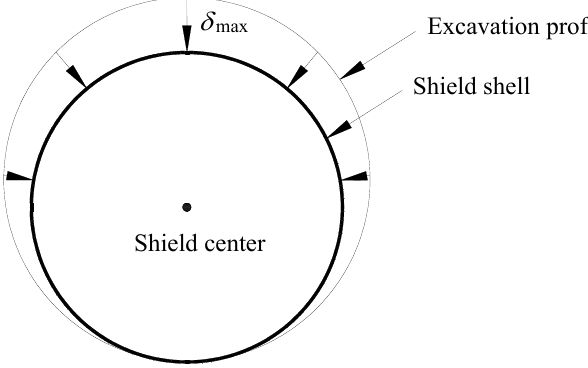
Figure 4. Schematic diagram of the convergent displacement method.